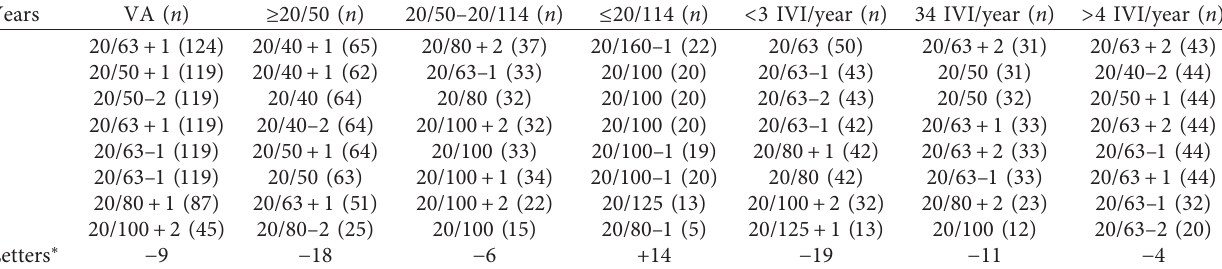
Table 1: Mean VA development for the respective cohort from baseline to each year in total, separated in baseline VA and amount of intravitreal injections/year in Snellen.